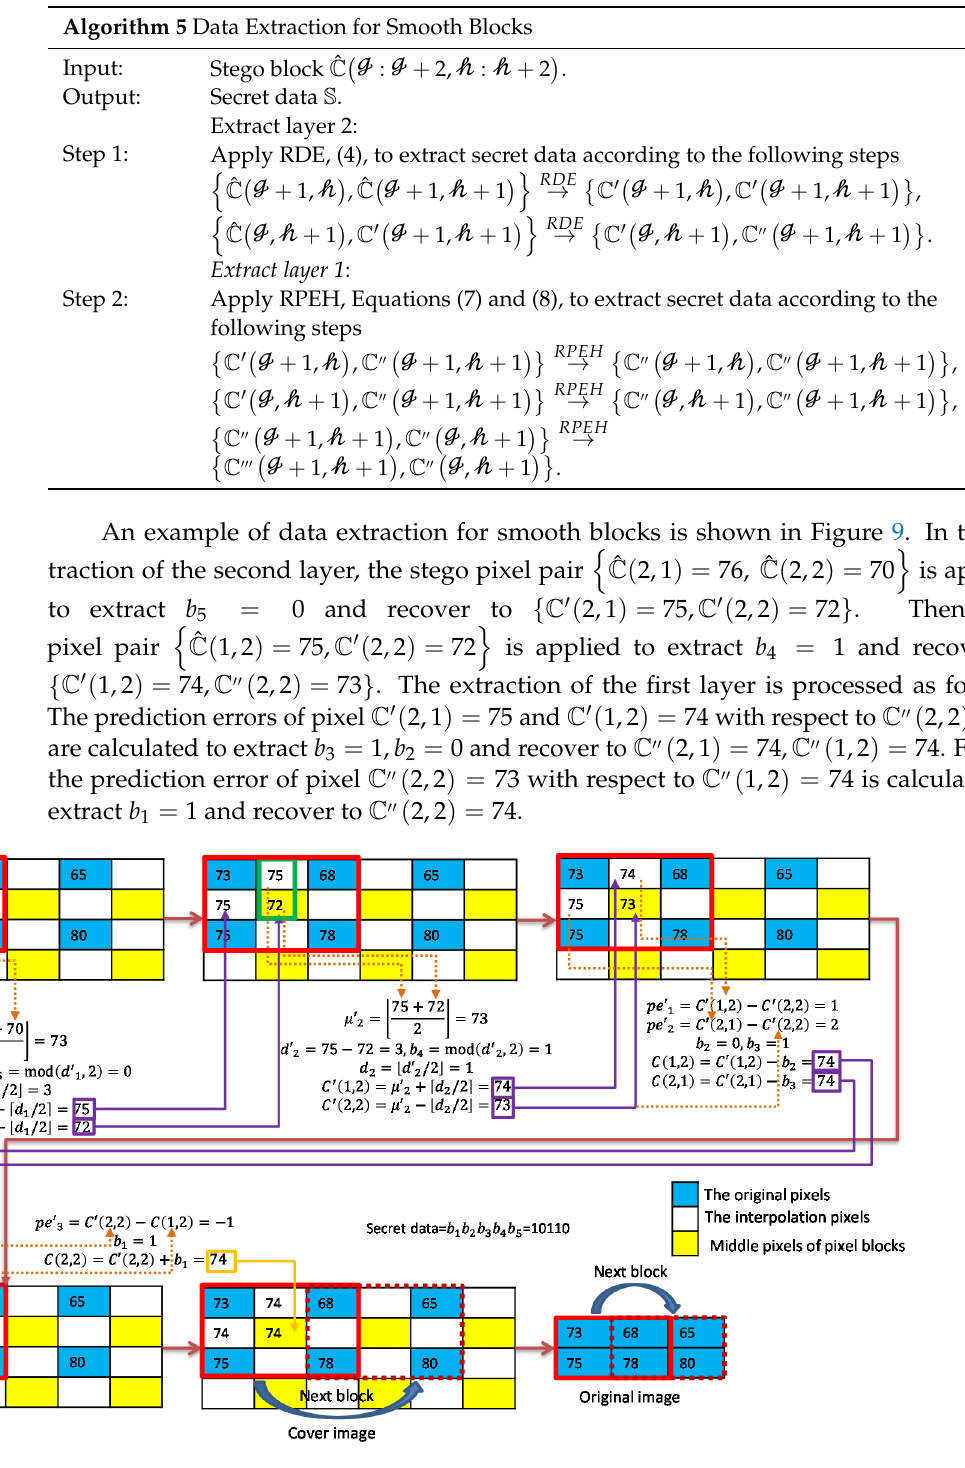
Figure 6. Example of interpolation and data embedding for complex blocks.